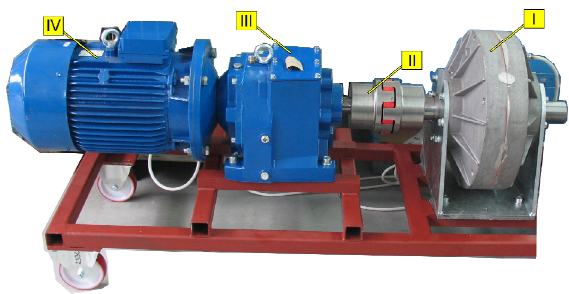
Fig. 6. Block scheme of laboratory setup.